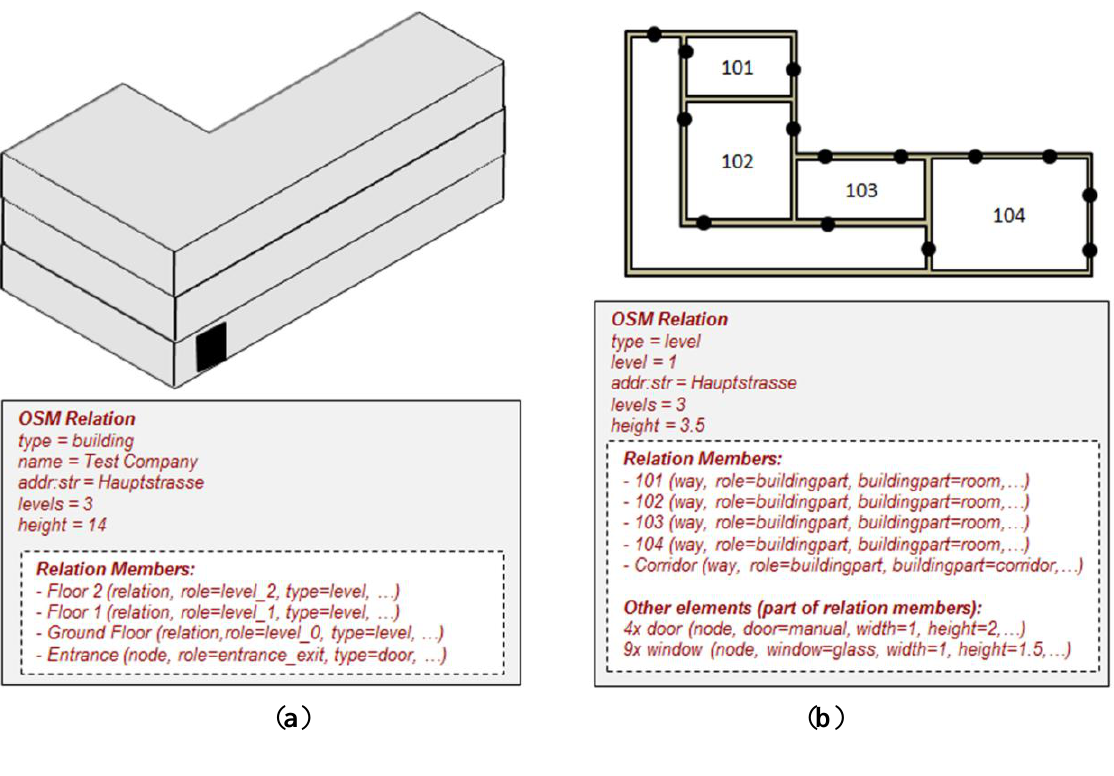
Figure 1. The basic hierarchy of a complete building ( a ) and an exemplary detailed floor plan with rooms, corridor, doors and windows ( b ) in IndoorOSM